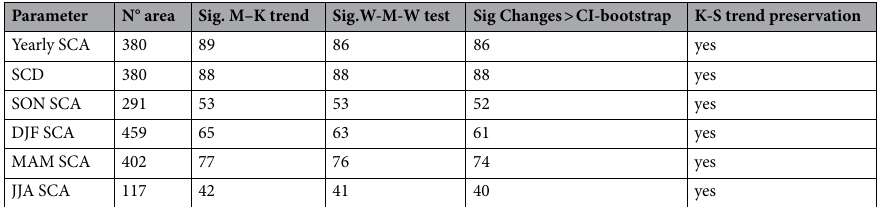
Table 4. Statistical analysis for the different parameters: N° area-total number of areas analyzed; Sig. M–K trend: the areas with significant trends at 5% level for Mann–Kendall (M–K); Sig. W-M-W test: the areas found with no significant difference for the Wilcoxon-Mann-Withney (W-M-W) statistics; Sig. Changes > CI-Bootstrap: areas whose changes are larger than the uncertainties associated with the downscaling procedure and defined with the Confidence Interval of the bootstrap approach; K-S trend preservation: check for the trend preservation with Kolmogorov–Smirnov (K-S) at 5% significance